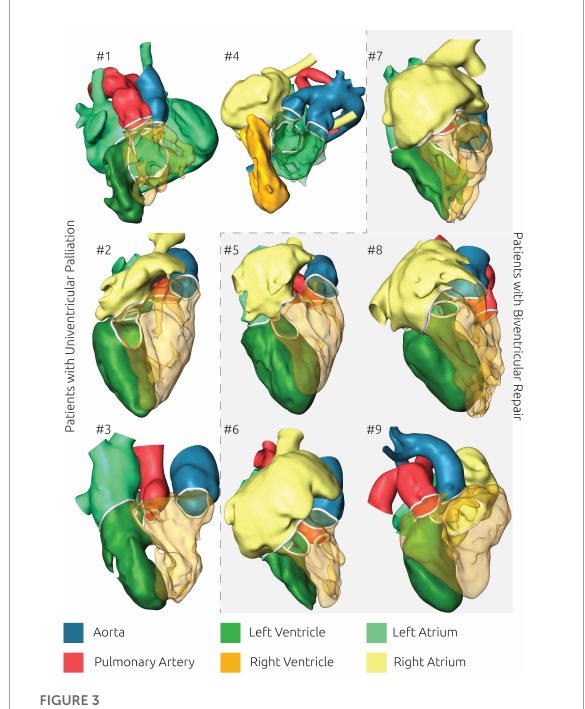
FIGURE3 Overview of all reconstructed surface geometries using the same color scheme for highlighting all anatomical structures. Patients with biventricular repair are shown with a gray